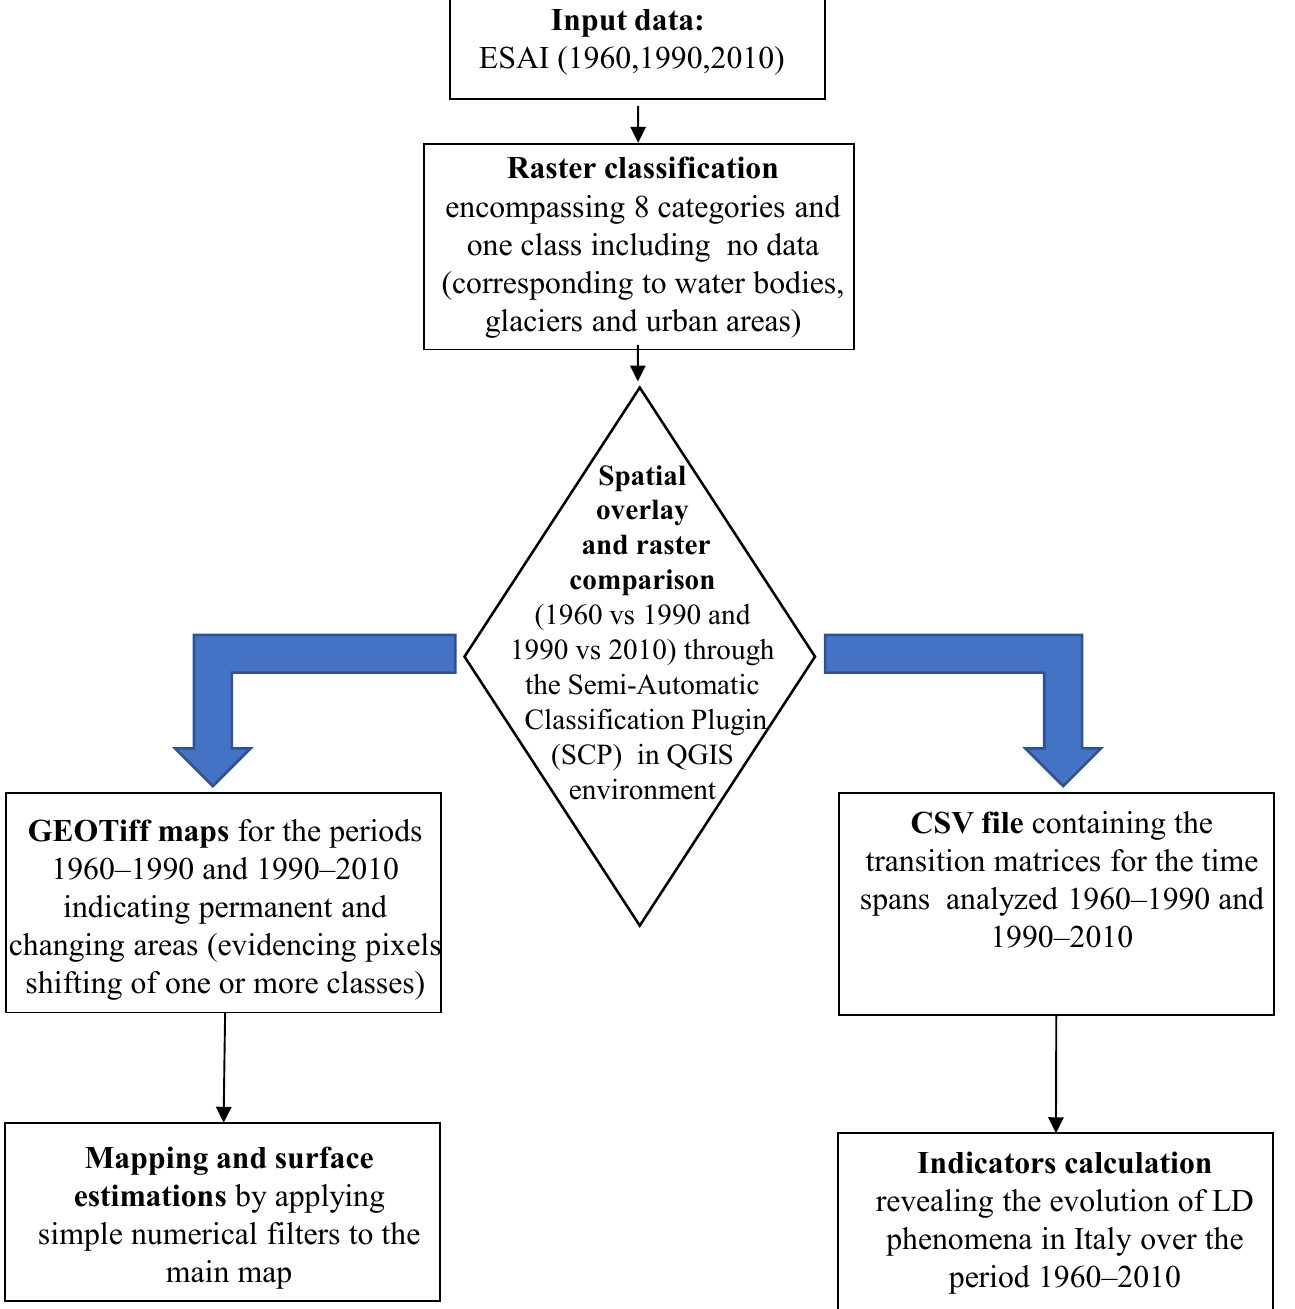
Figure 2. Flowchart of the adopted procedure.